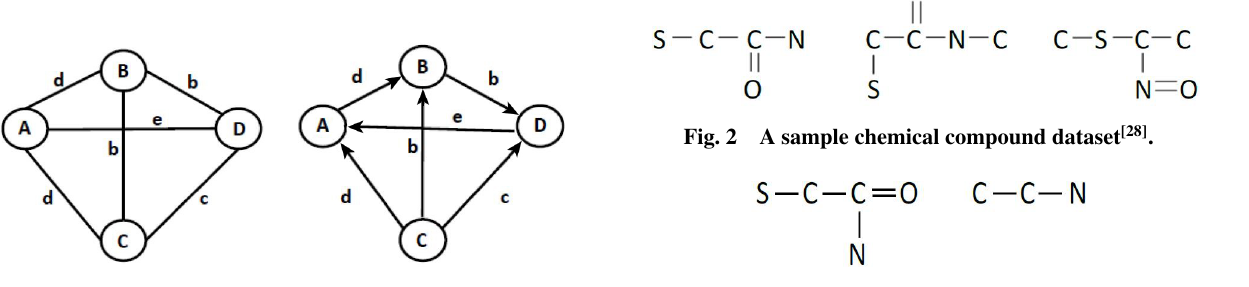
Fig. 3 Frequent subgraphs (left: support 2, right: support